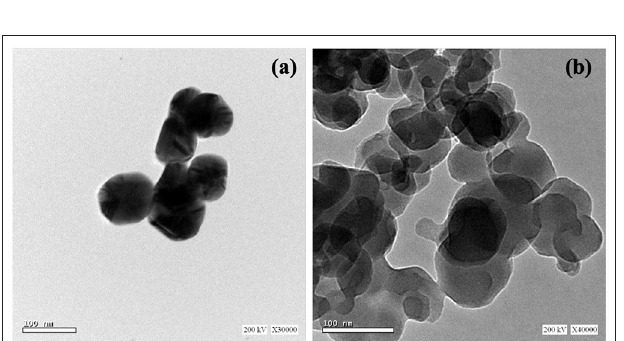
FIGURE 4 | Low resolution (a) and high resolution (b) TEM images of ZnO NPs recovered from spent Zn-C batteries via thermal route. This figure was reproduced from Farzana et al. (2018) under the terms and conditions of the Creative Commons Attribution (CC BY) license (http://creativecommons.org/